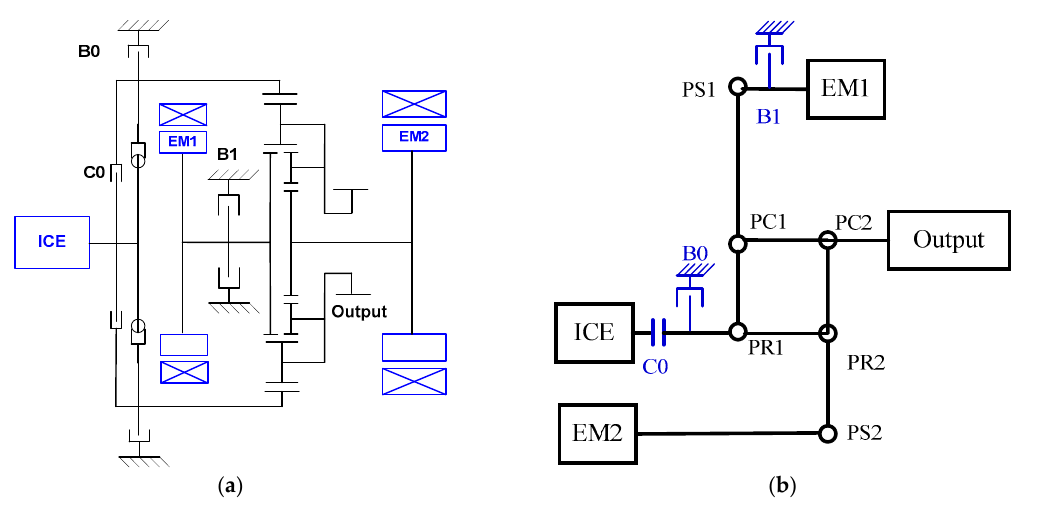
Figure 1. ( a ) Proposed configuration of the MMPS powertrain; ( b ) scheme of the Multi-Mode Power-Split (MMPS) powertrain.